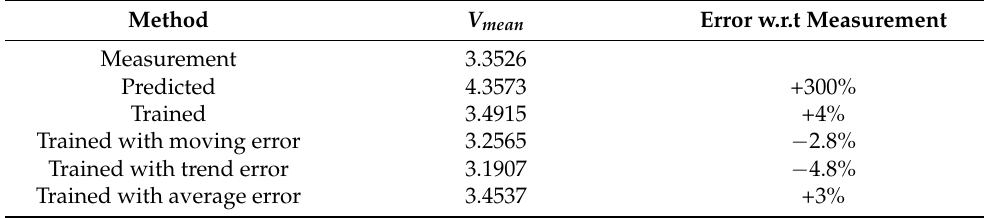
Table 7. Error estimation of the Lognormal